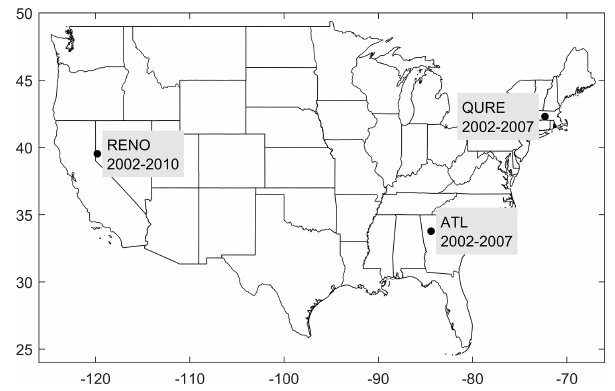
Figure 1. Location and data coverage of the PM 2 . 5 monitoring sites QURE, RENO, and